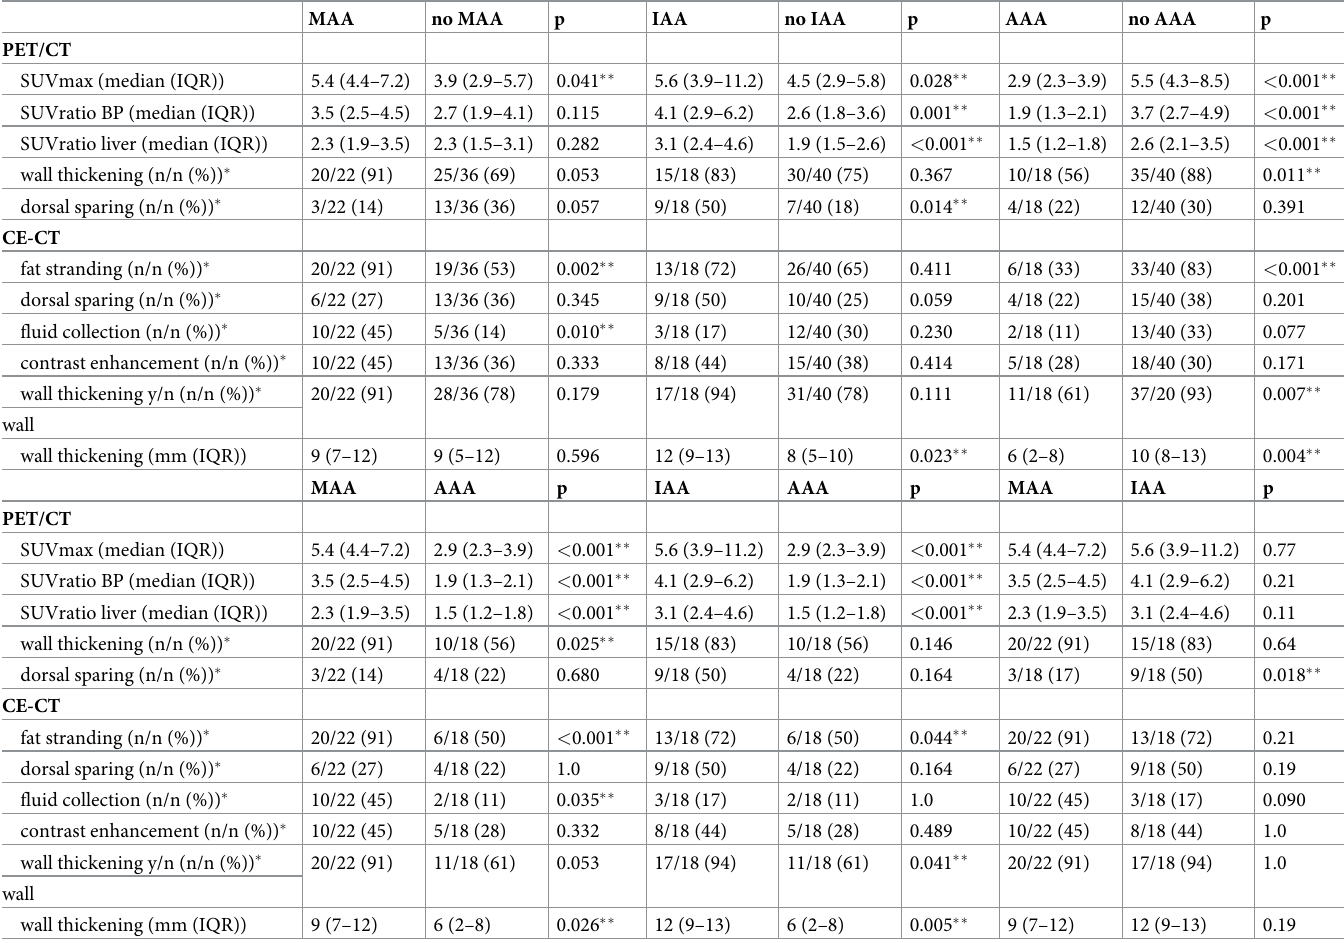
Table 3. Relevance of imaging characteristics in PET/CT and CE-CT for diagnosis of MAA, IAA and AAA—combined for both readers.